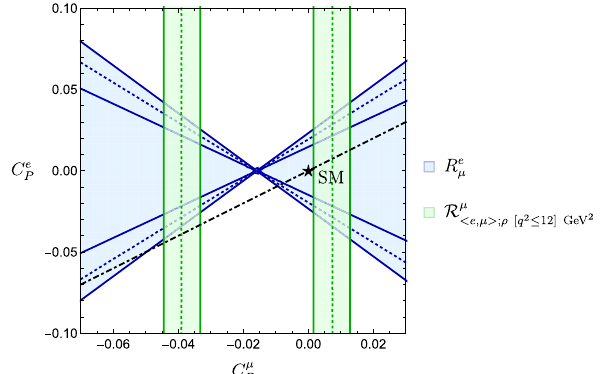
μ Fig. 7 Allowedregionsinthe C – C e planeutilizingtheratios R e μ and P P R μ . The dashed-dotted line indicates the correlation (cid:3) e ,μ (cid:4); ρ [ q 2 ≤ 12 ] GeV 2 = C μ arising for C e P P μ contours. Since the Wilson coefficients C and C e are corre- P P lated, we may in addition include the ratio R e μ to obtain even = C μ , this observable yields stronger constraints. For C e P P the blue region in Fig. 6, selecting the right green band and μ < excluding solutions 3 and 4 satisfying C P